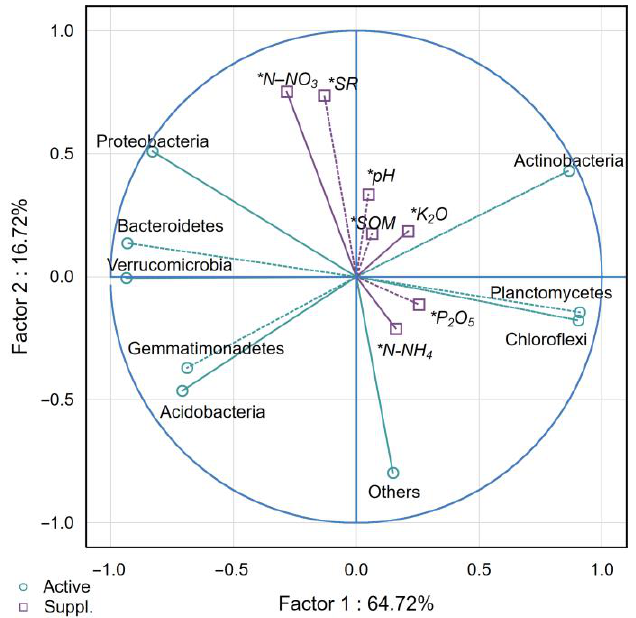
Figure 4. Factor loadings plots of the abundance of bacterial phyla and the soil physicochemical properties on main principal components. The length of the arrows approximates the variance of the variables, whereas the angles among them estimate their correlations.